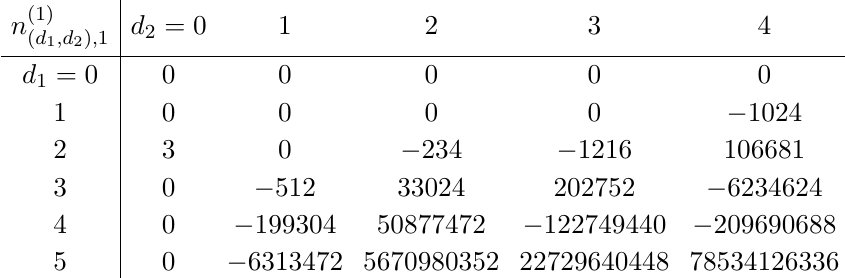
Table 31 . Genus 1 Gopakumar-Vafa invariants for X (4)